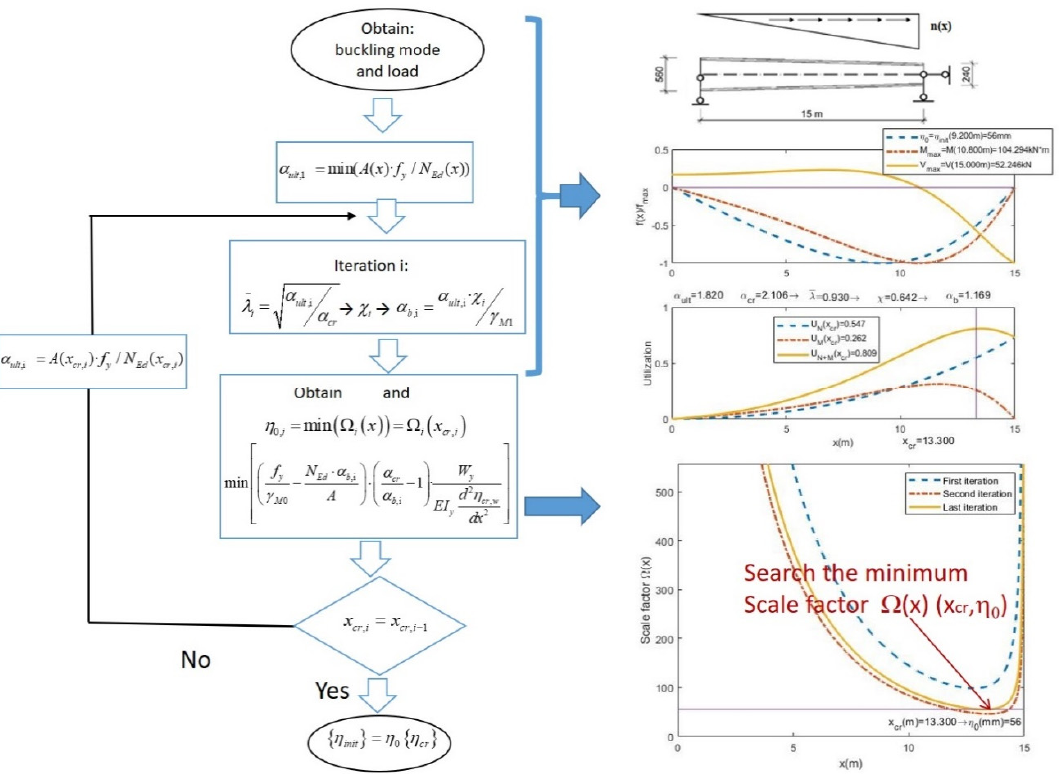
Figure 1. Flow chart describing the procedure on how to obtain the location of the critical section x cr and the unique global and local initial (UGLI) imperfection amplitude η 0 . Illustrative example.